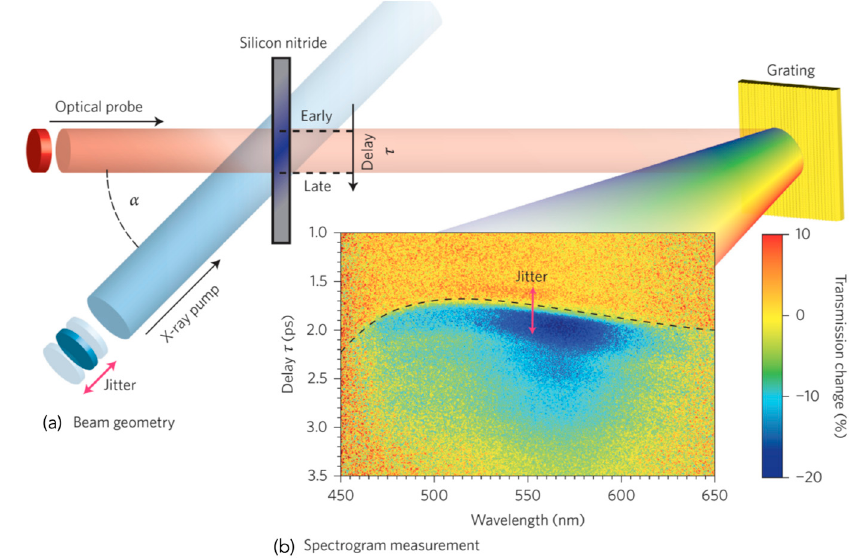
Figure 12. Schematic of the single-shot geometry for measurement of the spectrogram. ( a ) The X-ray and optical beams are crossed in a silicon nitride membrane and their relative delay is encoded in the spatial beam profile of the optical probe. The crossing angle α and beam diameters define the time window in which the X-ray-induced absorption is probed. ( b ) Measured spectrogram using an unpumped normalization spectrogram to calculate the change in transmission. The result of the two-step edge-finding algorithm to determine the X-ray arrival time is overlaid as a black dashed line. Figure adapted from Reference [158] with permission from Springer Nature.